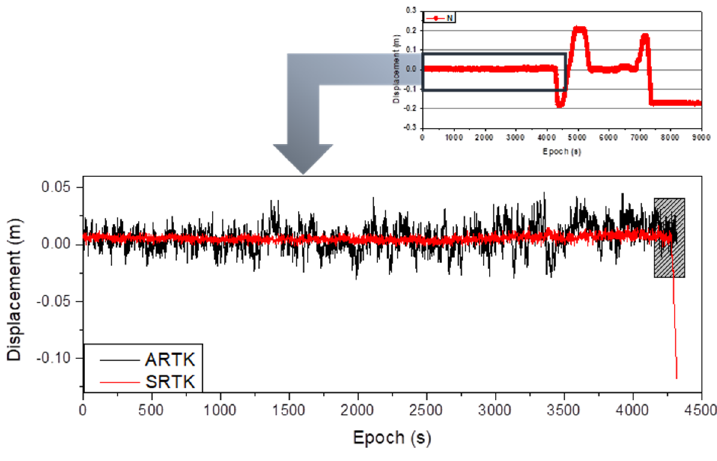
Figure 7. Simulated displacement of the reference station. Sensors 2020 , 20 , 1320